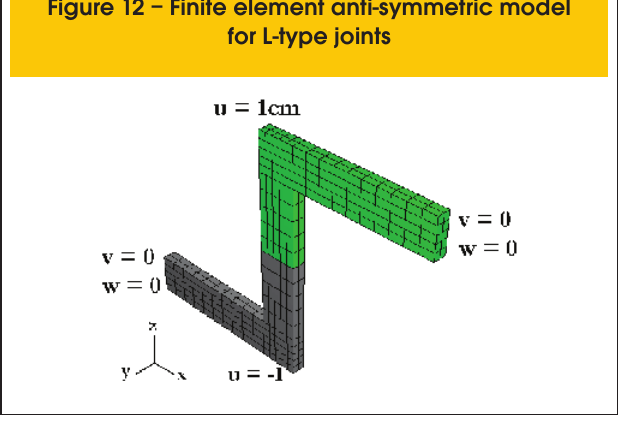
Figure 13 – Deformed configuration of the complete cross-type